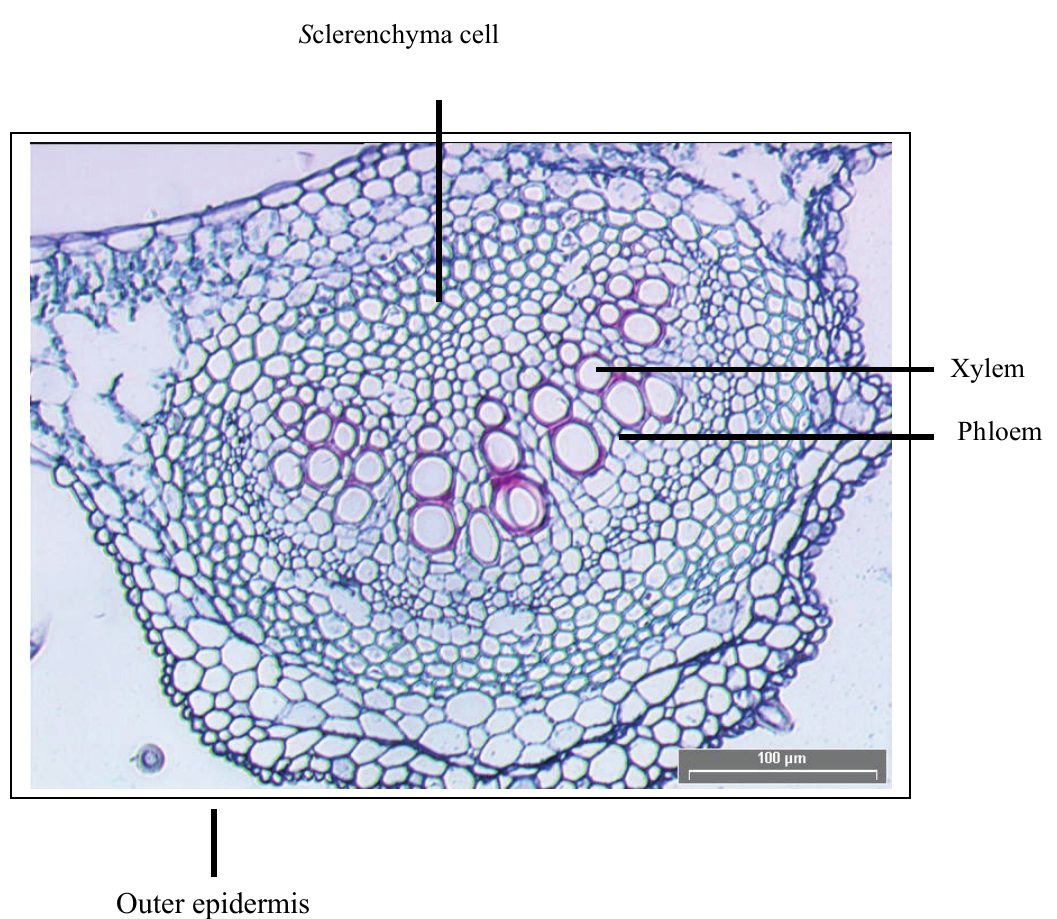
Figure 2. Transverse section of the leaf of C.